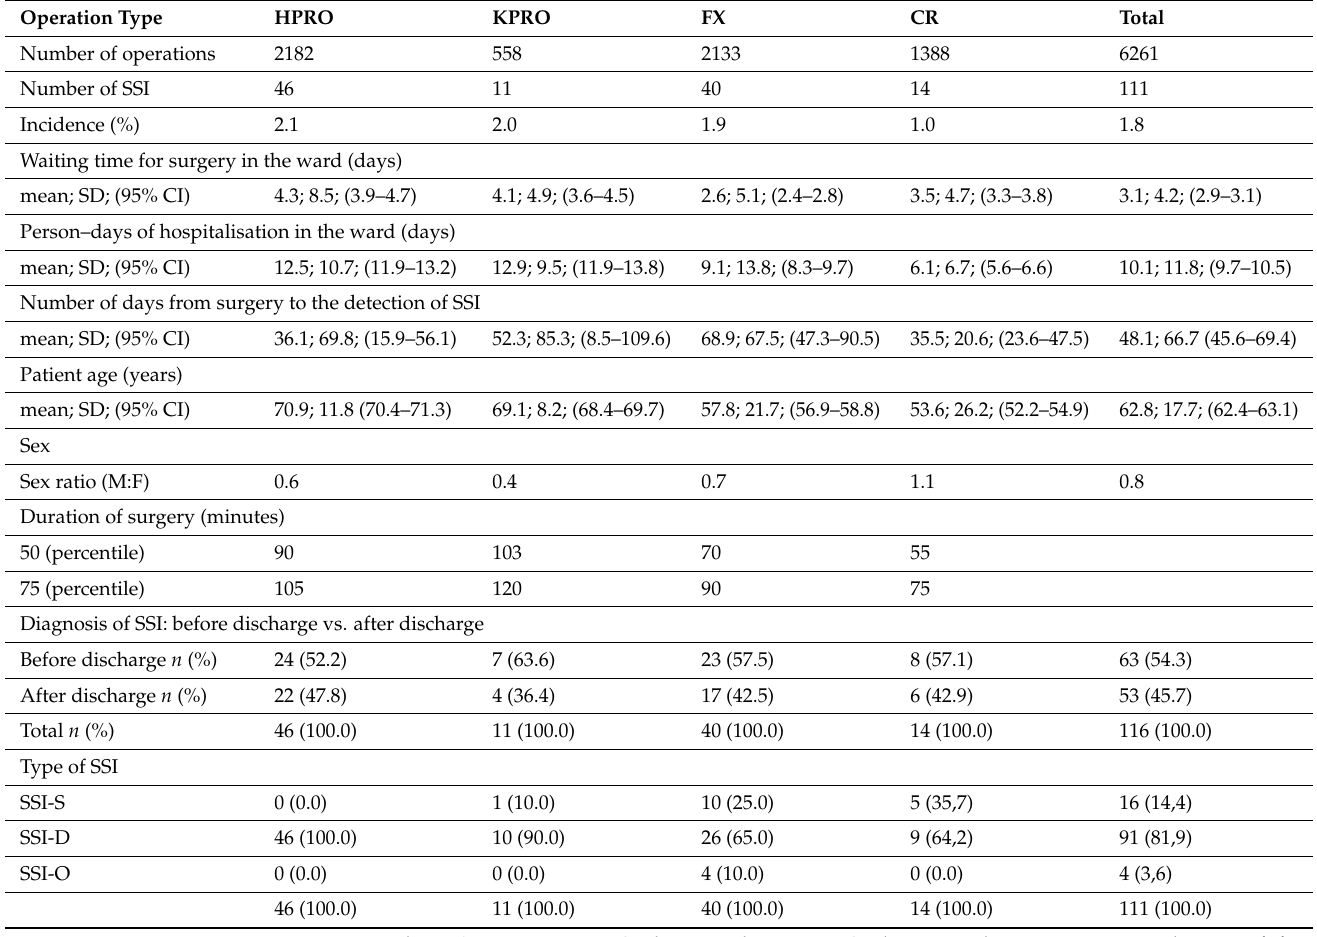
Table 2. Number and incidence of SSI considering variables: days of waiting for surgery, length of stay in the ward, number of days from surgery to the detection of SSI, patient age, patient sex, ASA score, surgical site cleanliness, duration of surgery, and detection of SSI before or after discharge for HPRO, KPRO, FX, and CR in